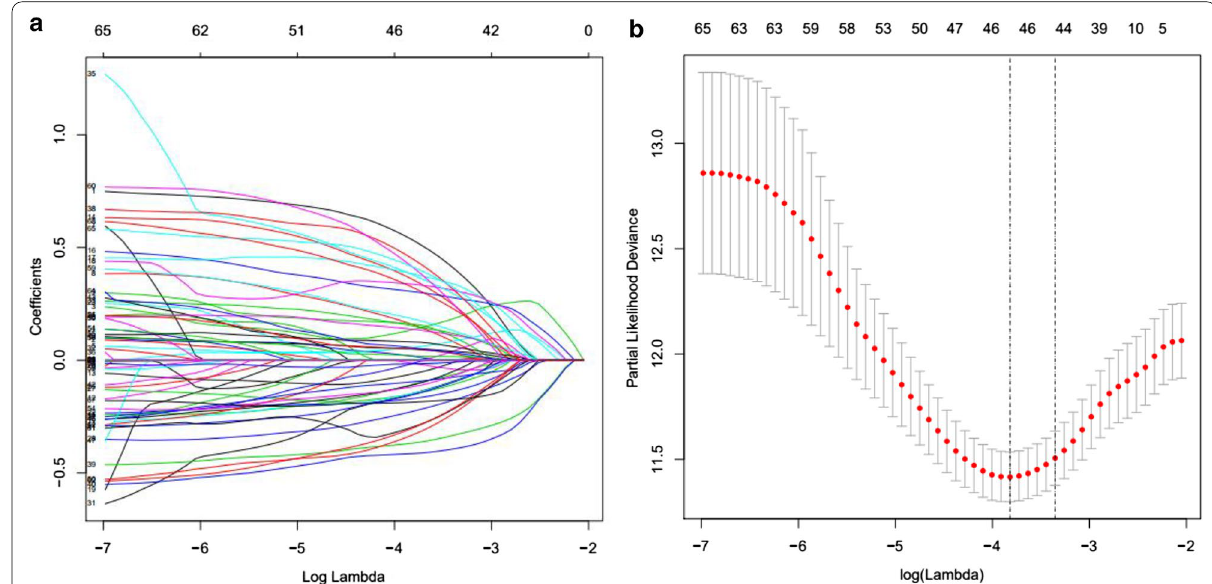
Fig. 6 The optimal survival-related DEASs were selected for constructing the prediction model by LASSO regression. a LASSO coefficient profiles of the candidate survival-related DEASs. A coefficient profile plot was produced against the log λ sequence. b Dotted vertical lines were drawn at the optimal values using the minimum criteria.